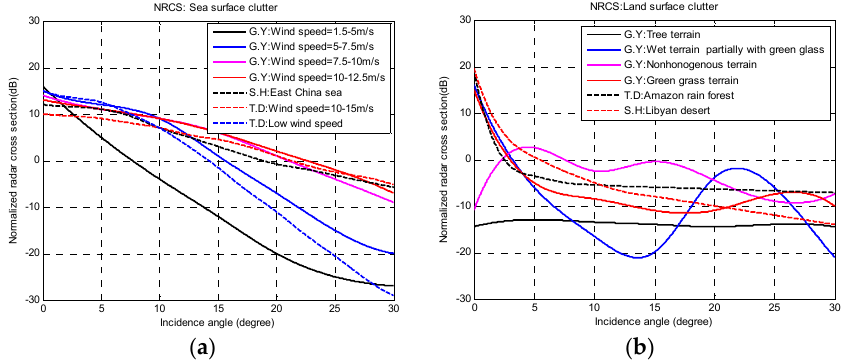
Figure 3. Normalized radar cross-section of sea and land surface clutter under different incidence angles; ( a ) sea surface clutter; G.Y, S.H, T.D separately show the NRCS data from Grant and Yaplee [22], Satake and Hanado [23], and Tanelli and Durden [24]; ( b ) land surface clutter.